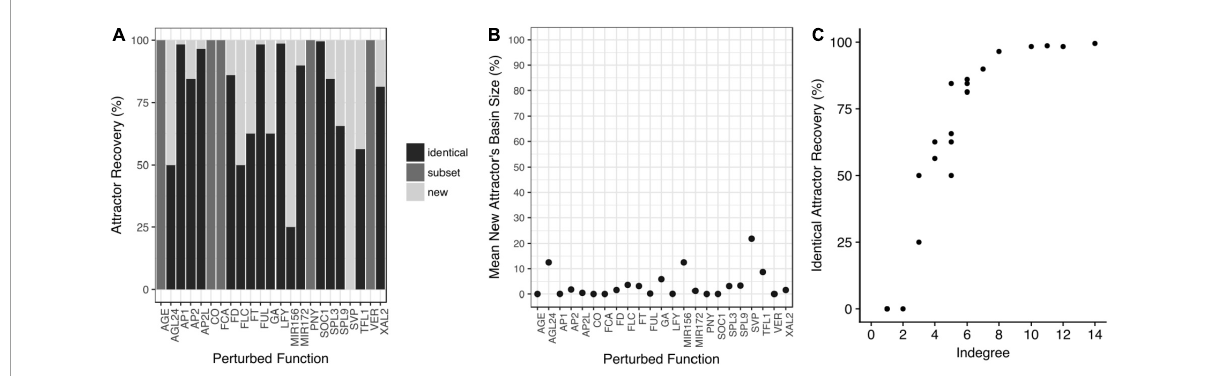
FIGURE5 The attractors are robust to perturbations of the Boolean functions. (A) Copies of the model were constructed with one-bit random perturbations in each node’s truth table. The attractors recovered by each perturbed model were compared with those obtained with the original model. In some cases, the perturbed models recovered identical attractors to the original model (identical); or they recovered a subset of the original attractors (subset), or both, original and new attractors appeared in the perturbed model (new). (B) The mean basin size of the new attractors is small. (C) The percentage of identical attractors recovery (robustness) increases with the indegree of the perturbed